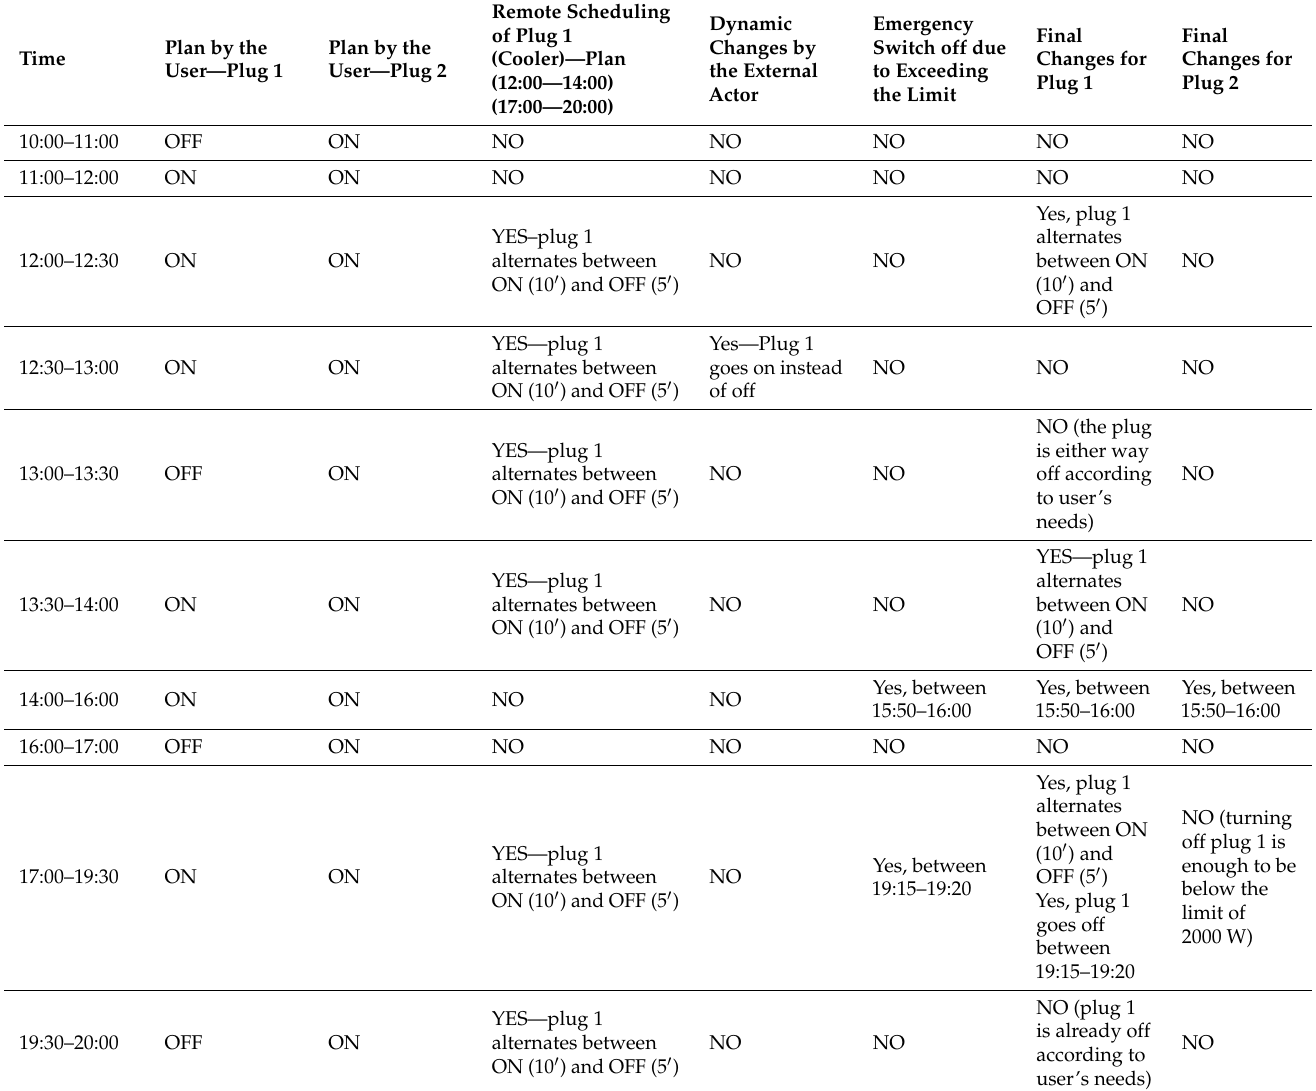
Table 5. Overall changes introduced by the external actor to the two